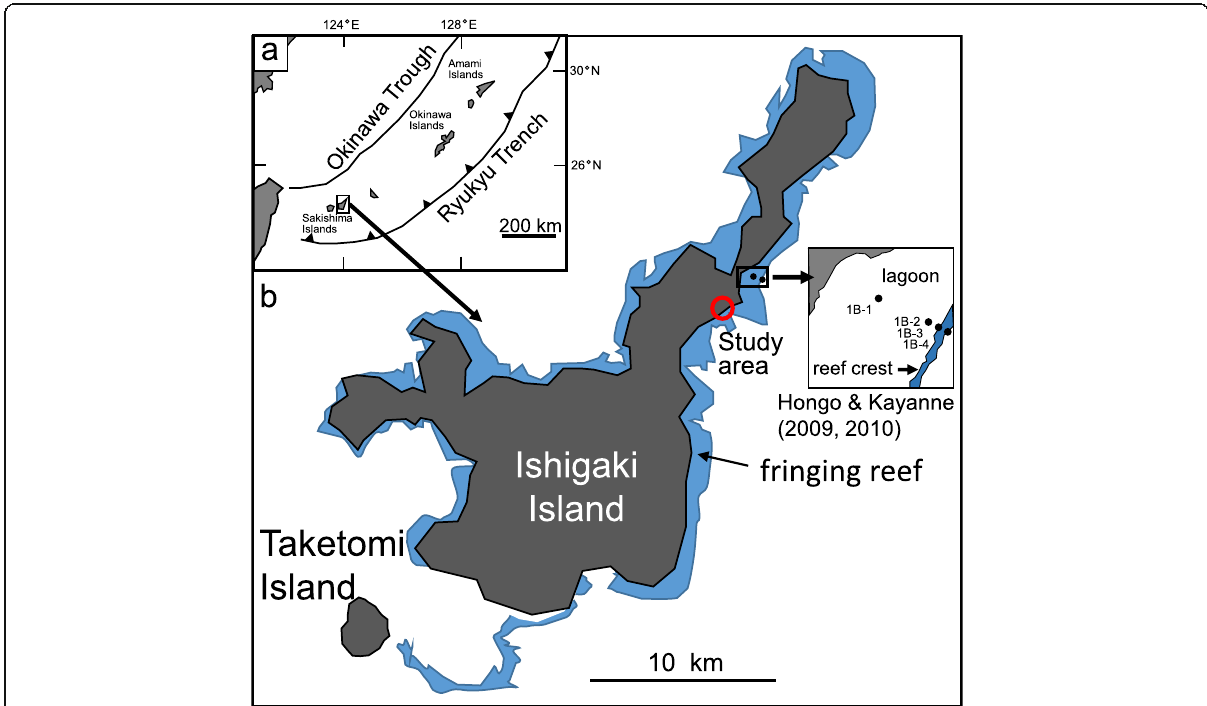
Fig. 1 Study location. a Plate boundaries around the southern Ryukyu Islands (after Ando et al. 2009). b Ishigaki Island, showing the location of the study area (after Goto et al. 2010)